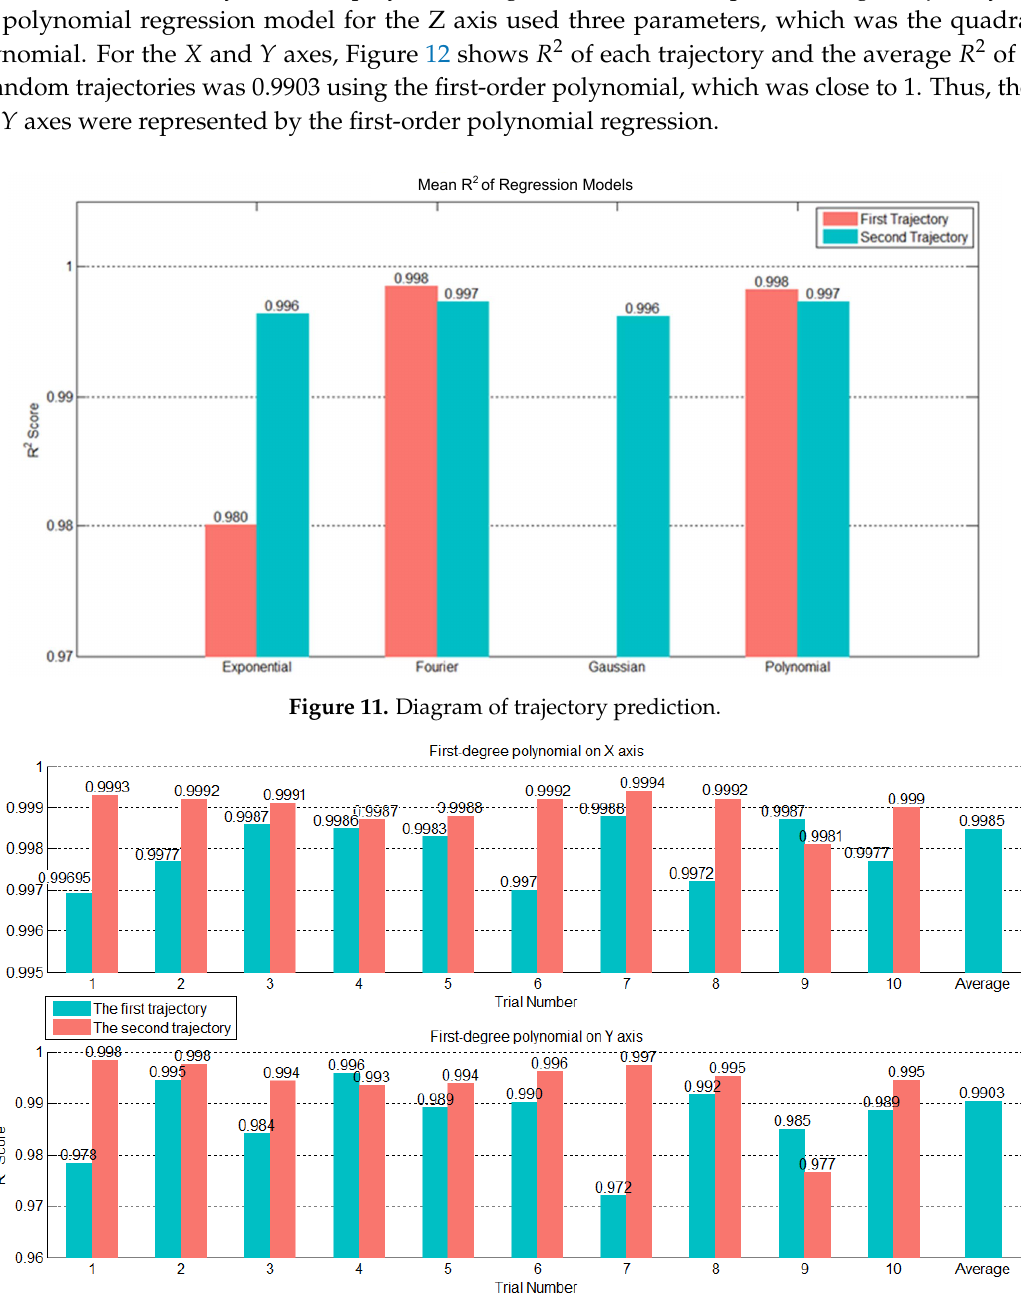
Figure 12. R 2 of the first-order polynomial regression on the X and Y